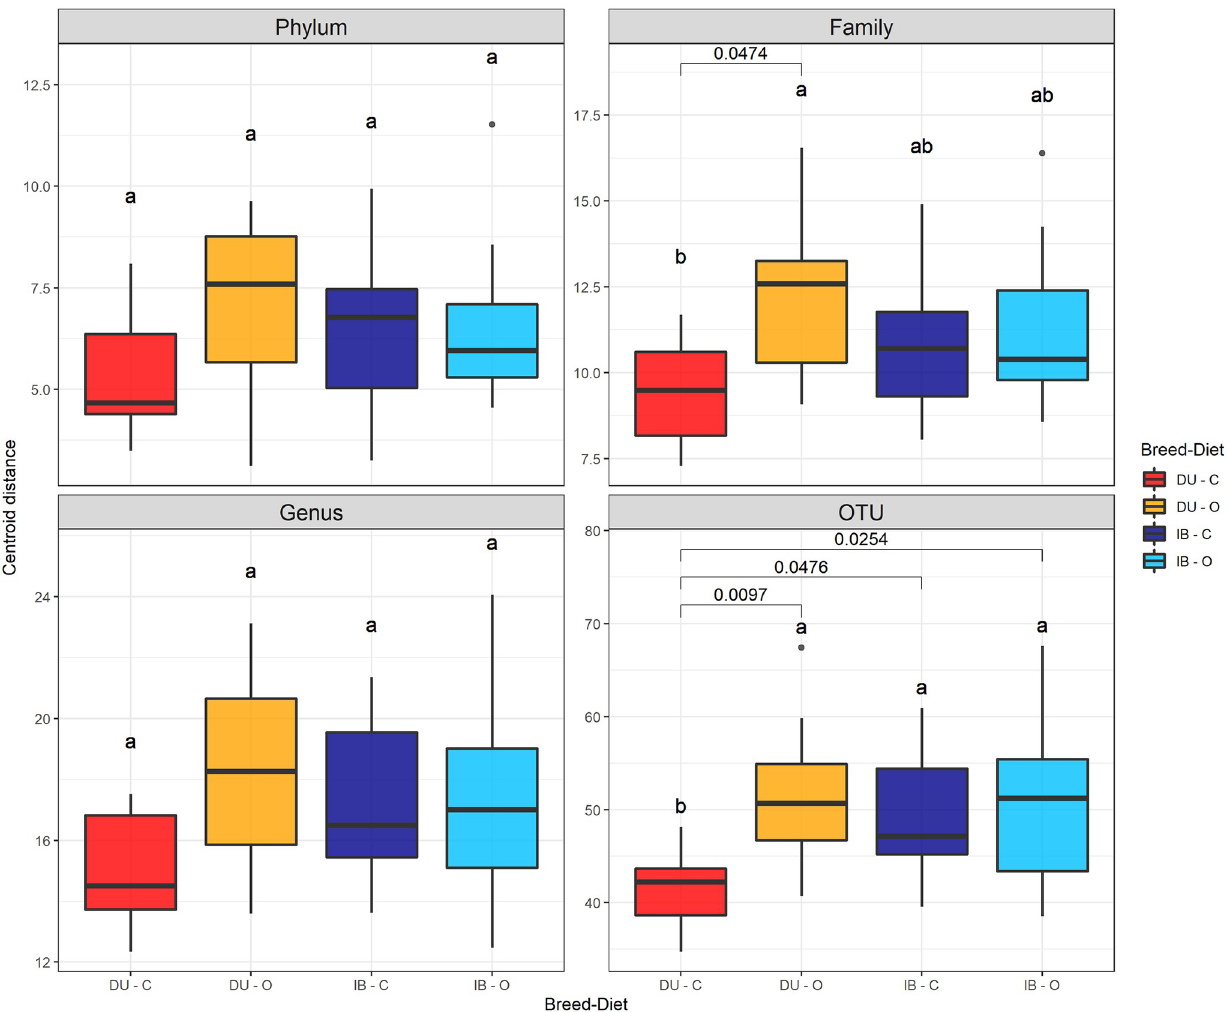
Fig 4. β -diversity indices. Beta-diversity indices by group at different feature glom levels. Tukey HSD test group letters and p-values for significant group comparisons (p < 0.05) are